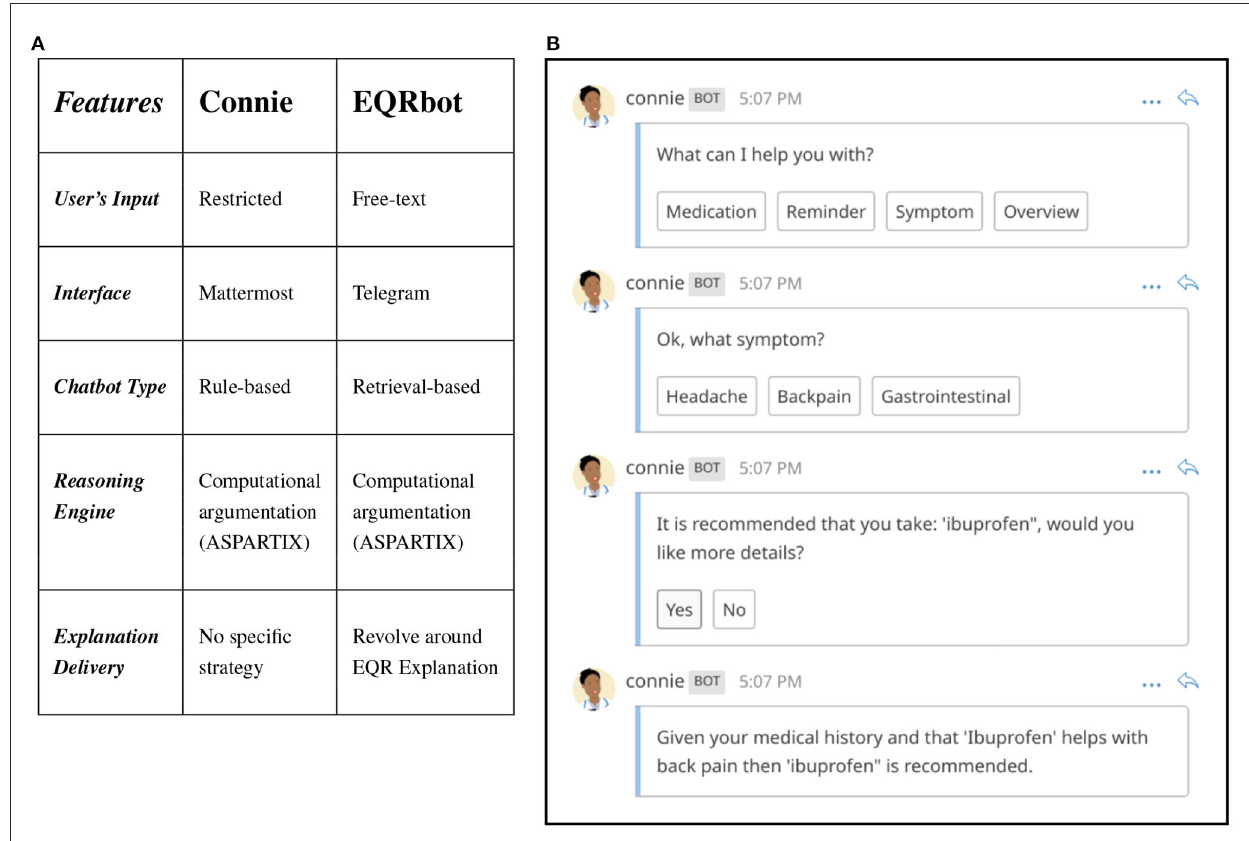
FIGURE4 (A) Comparison of EQRbot and Connie’s main features. (B) Example of interaction between a patient and